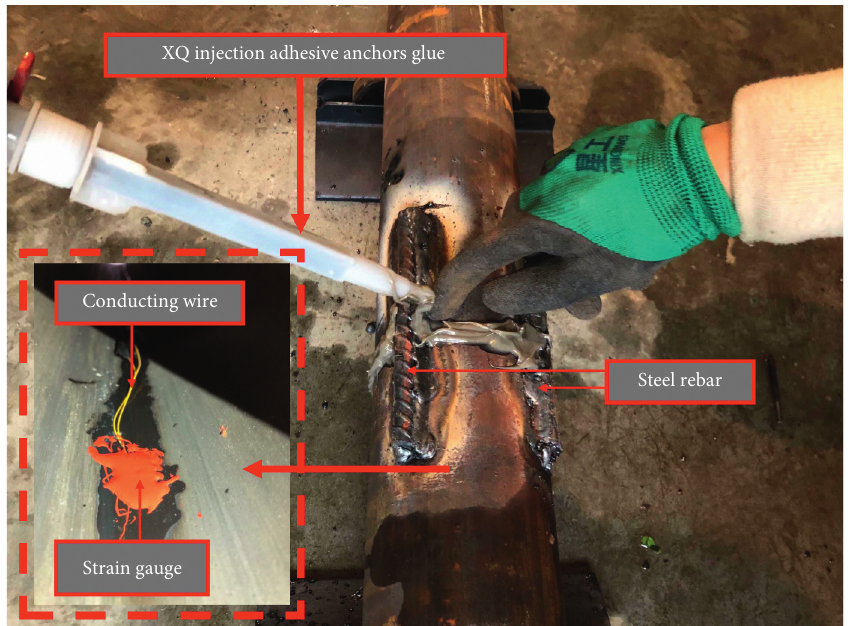
Figure 3: Pile segment splicing photos. At the bottom right of the picture is the pasting diagram of strain gauge on the inner wall of the test